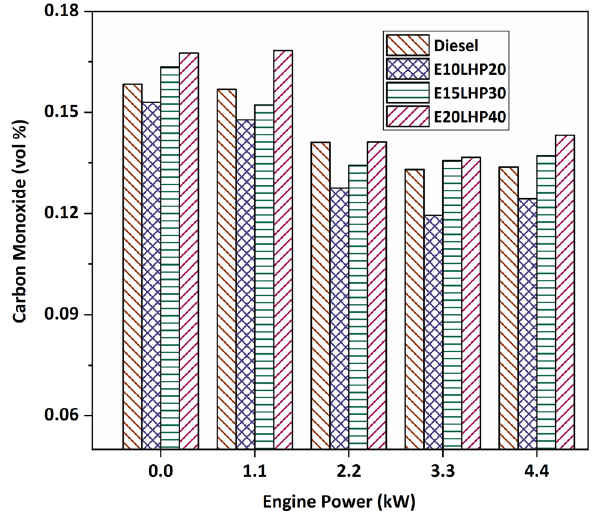
Figure 5. Impact of Carbon monoxide emissions on LHP and ethanol blends.